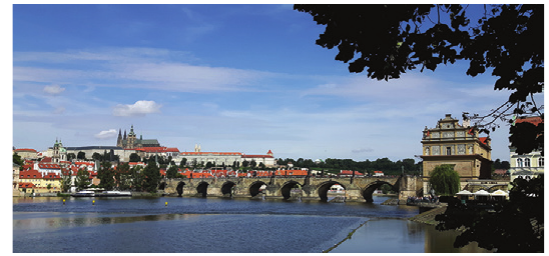
Fig. 1. Charles Bridge and Prague Castle panorama